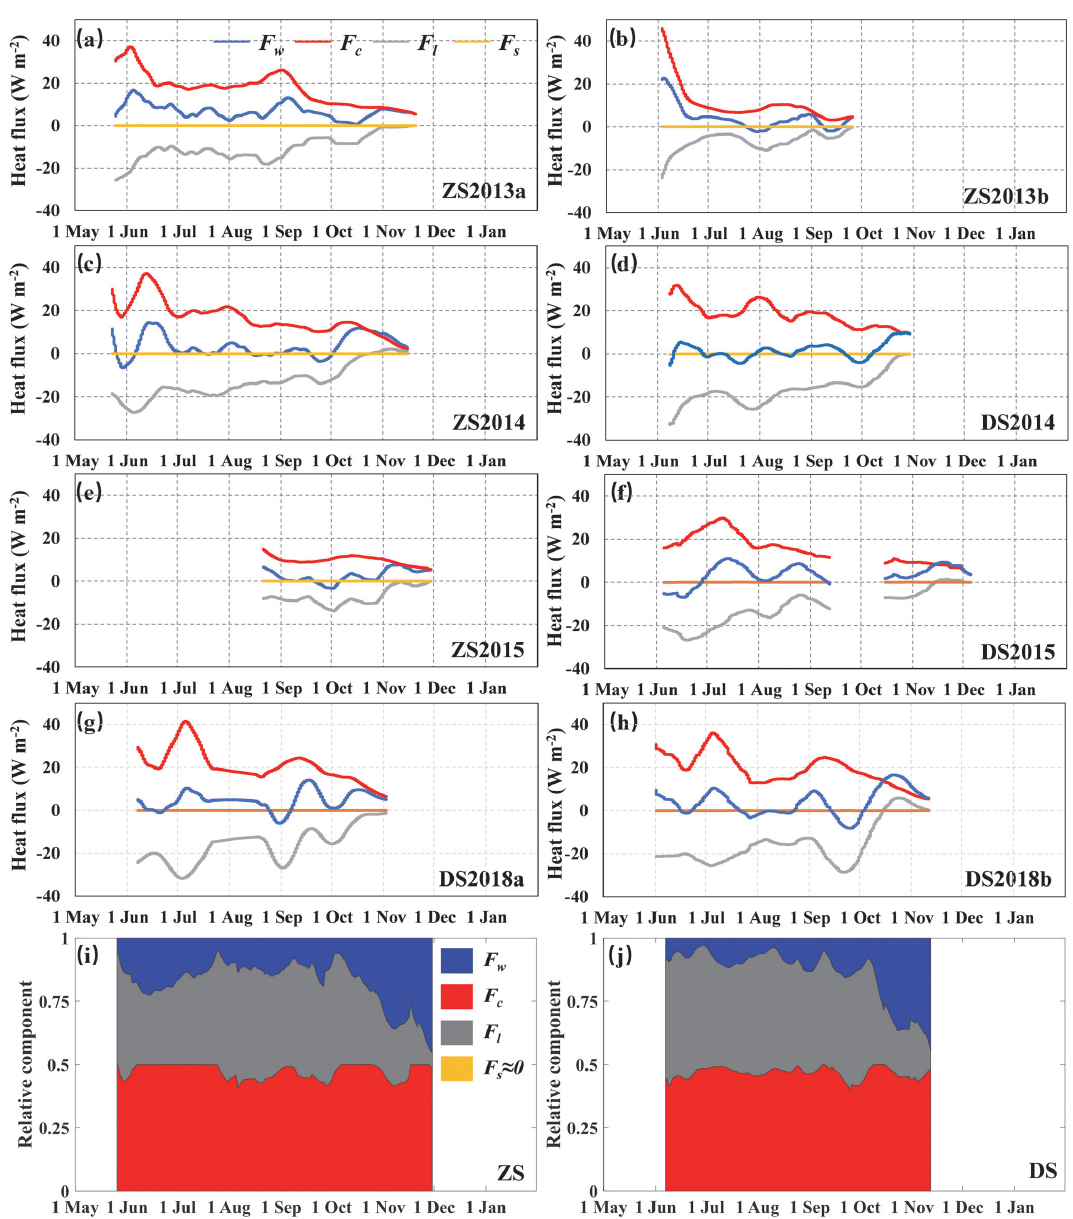
Figure 7. (a–h) Heat flux components obtained from the IMB observations at different sites, with the two panels in each row obtained in the same year, and the averaged relative contributions to the total heat balance at ice bottom of the (i) six sites at ZS and (j) five sites at